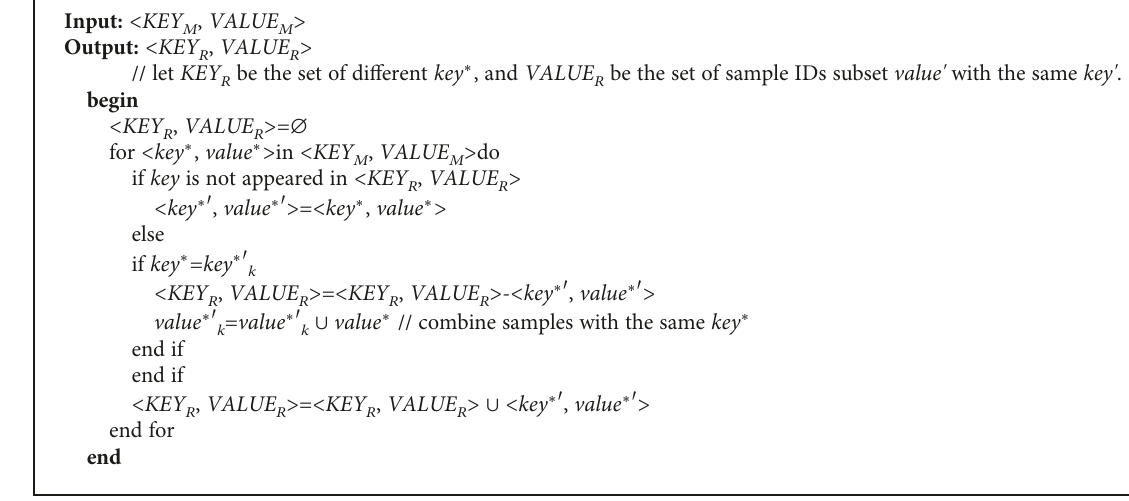
Algorithm 4: Single condition attribute subset